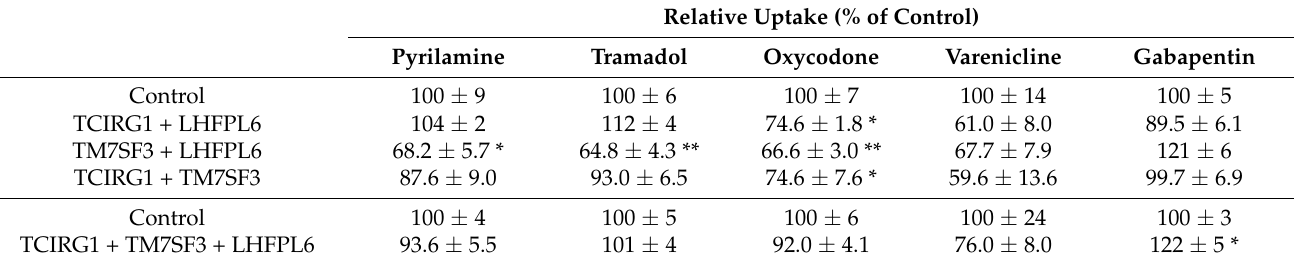
Table 3. Second functional screening by multiple gene knockdown. Relative Uptake (% of